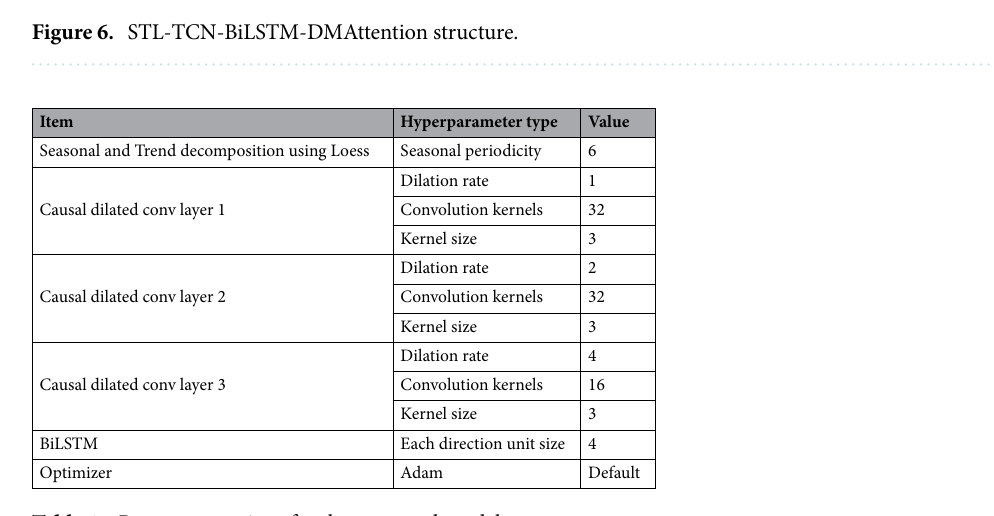
Table 1. Parameter settings for the proposed